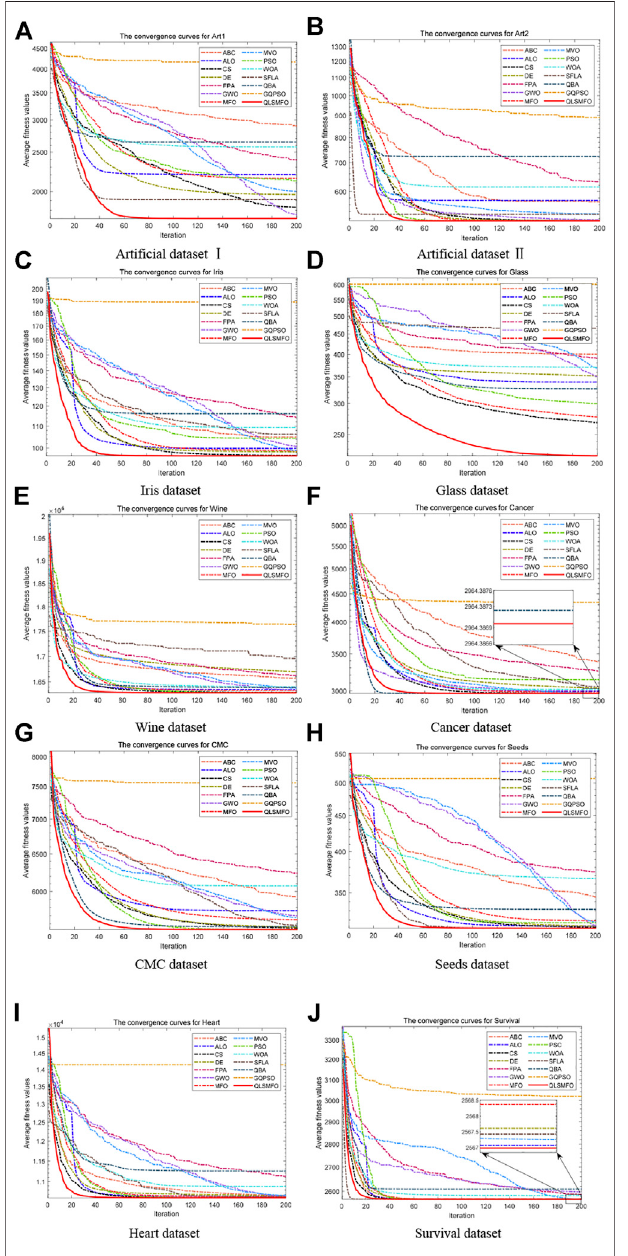
FIGURE5| Convergencecurvesofallalgorithmsonthe10datasets. (A) Arti fi cialDatasetI. (B) Arti fi cialDatasetII. (C) Irisdataset. (D) Glassdataset. (E) Wine dataset. (F) Cancer dataset. (G) CMC dataset. (H) Seeds dataset. (I) Heart dataset. (J) Survival dataset.